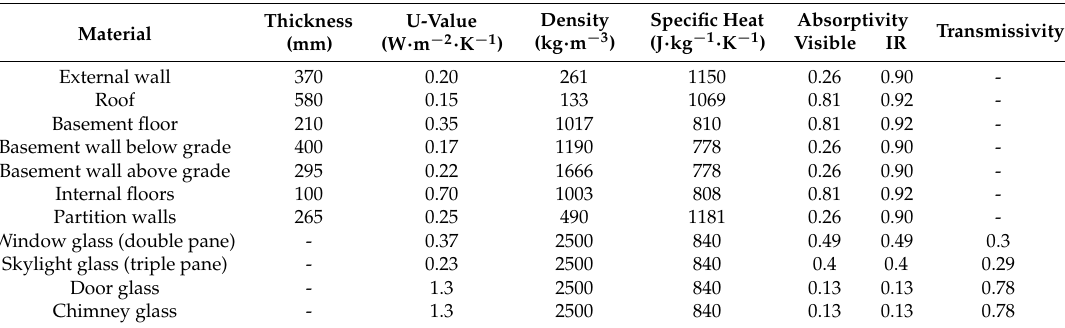
Table 1. Construction material